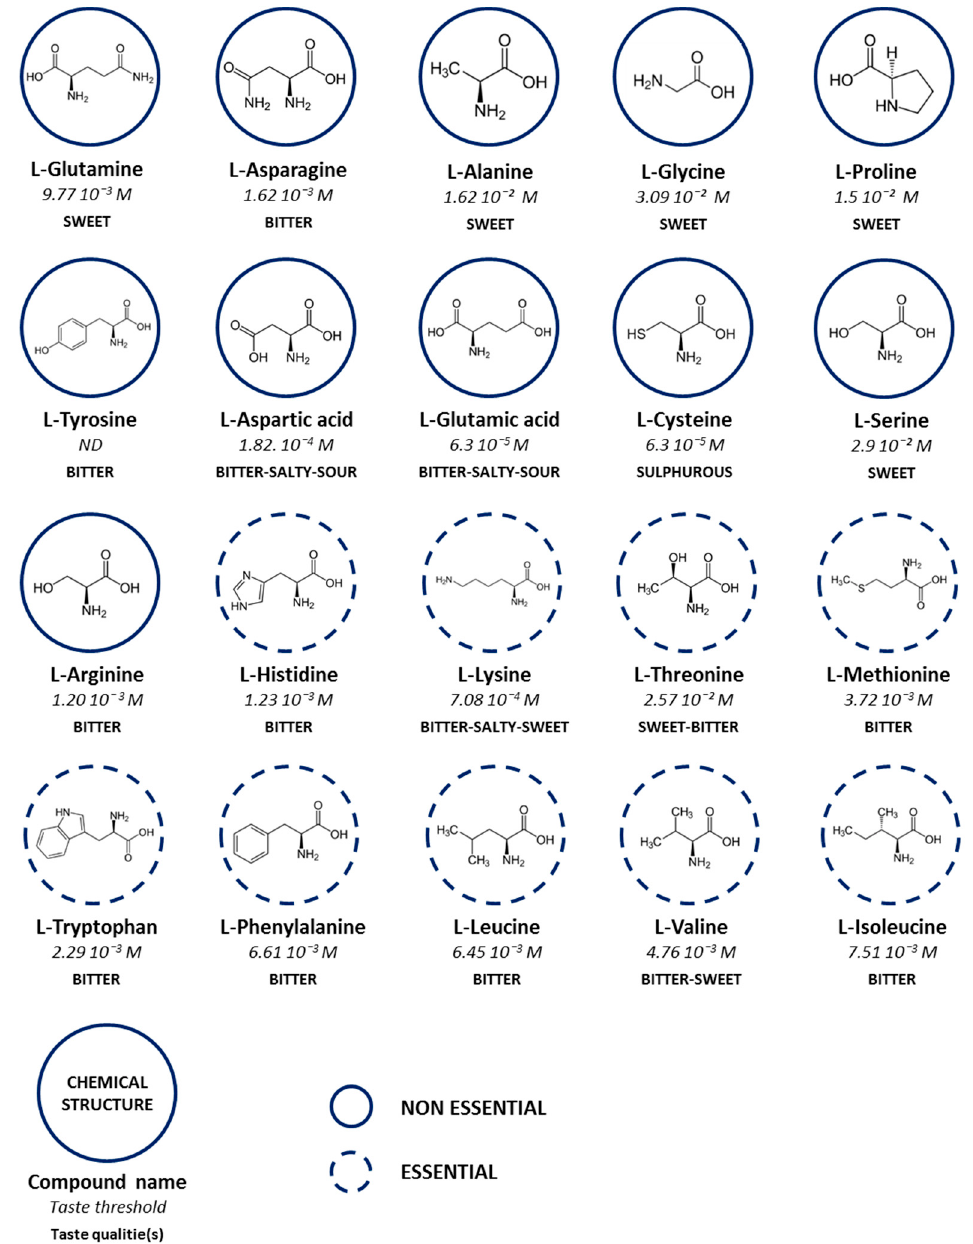
Figure 1. Structure, detection threshold values and taste qualities of the 20 L -amino acids [18]. Amino acids have been classified according to their availability for the body. ND, Not Determined. Table 1. Comparison between threshold concentrations and higher levels of L -amino acids concentrations in 22 g of effervescent powder dissolved in a volume of 200 mL of water. This powder is a unique complex of amino acids from pure protein sources, whey protein, and calcium caseinates (Nutritional Technologies International, Optizone ™).